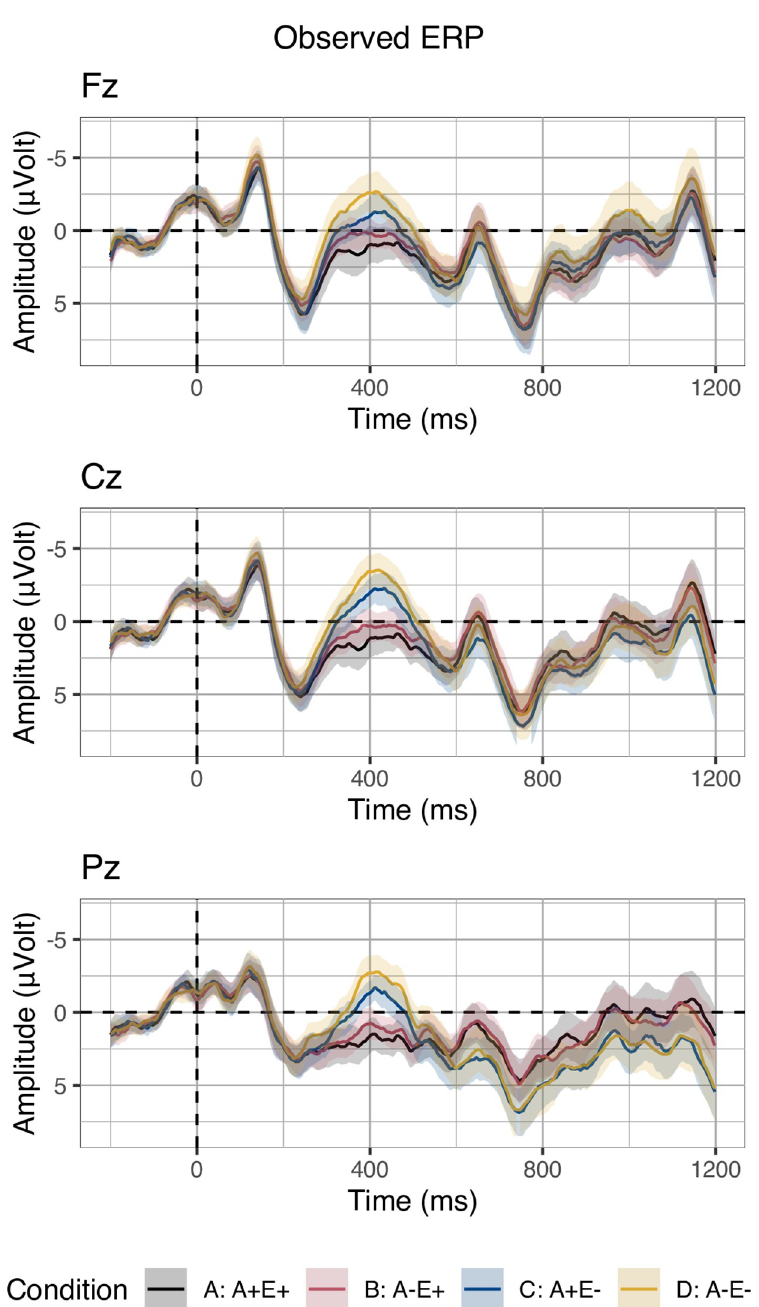
Fig 1. Grand-average ERPs. Grand-average ERPs on three midline electrodes in the four conditions crossing adverbial clause association and expectancy. Negative voltages are plotted upwards. Ribbons indicate standard error computed from the per-subject per-condition